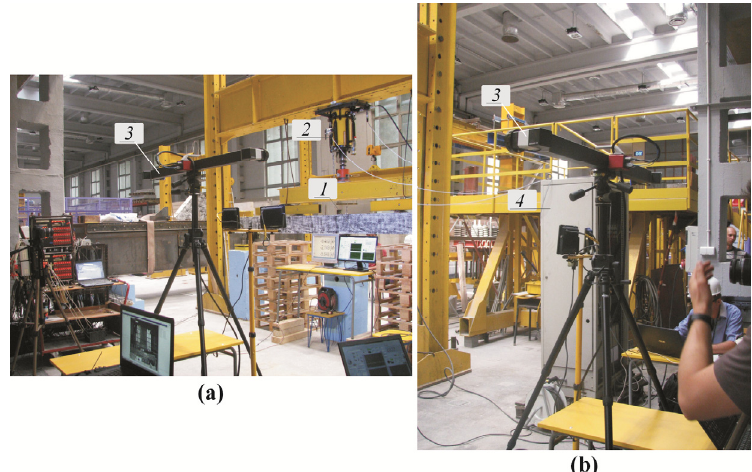
Figure 11. Reinforced concrete elements at the test stand: ( a ) from the side of optical measurements, ( b ) from the side of making observations of cracks; 1—test element, 2—hydraulic actuator, 3—electro-resistant dynamometer, 4—steel beams for load distribution; 5—supports of the test stand.